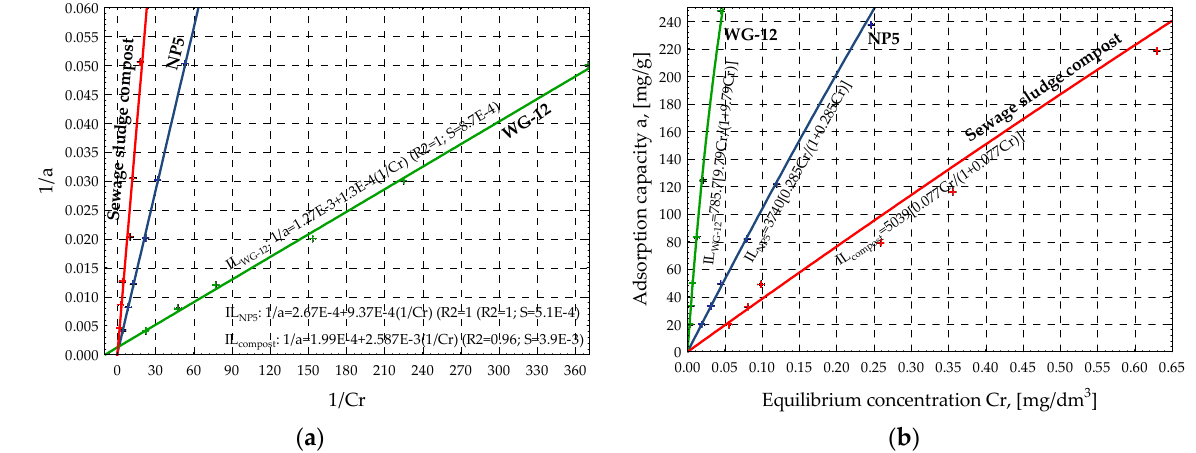
Figure 3. Graphs of linear isotherms ( a ) and classic isotherms ( b ) according to Langmuir for tested sorbents.